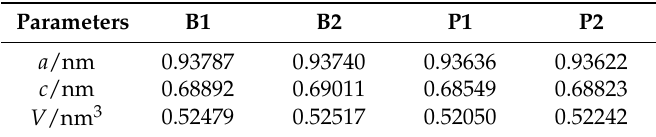
Table 3. Lattice parameters of HAP in bones of Cololabis saira .